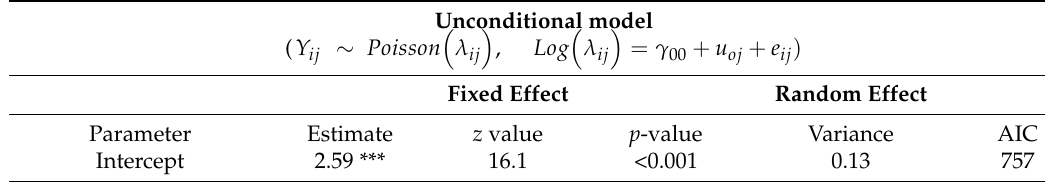
Table 3. Unconditional ( upper ) and hierarchical Poisson regression ( lower ) models of the density of (cid:17) (cid:16) Y ij Korean fir with plot-level explanatory variables using the maximum likelihood method (Laplace